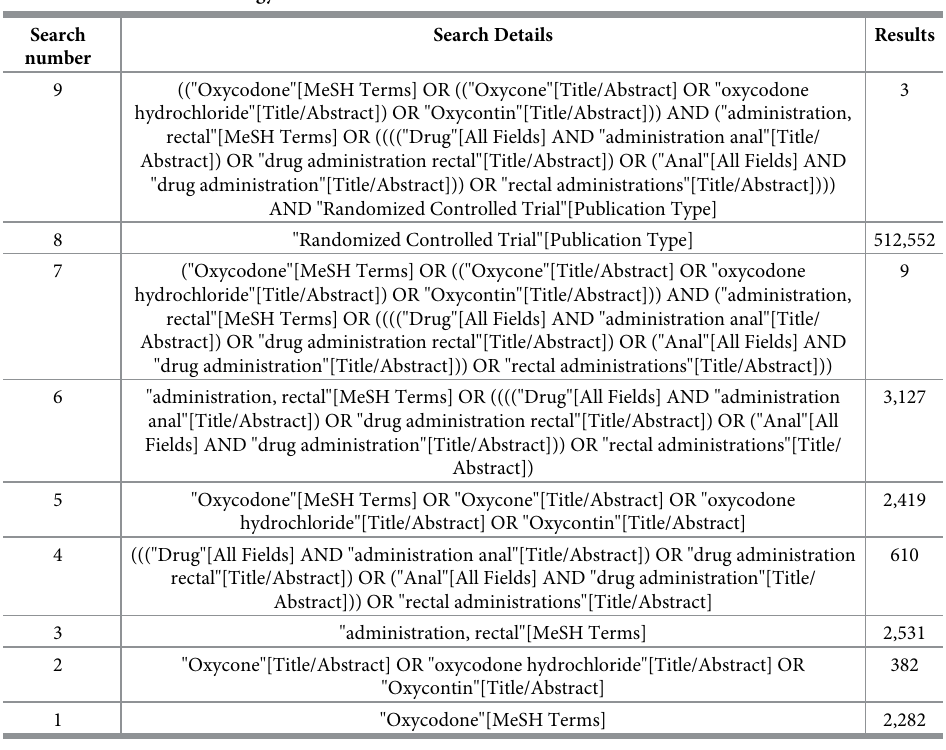
Table 1. Pubmed search